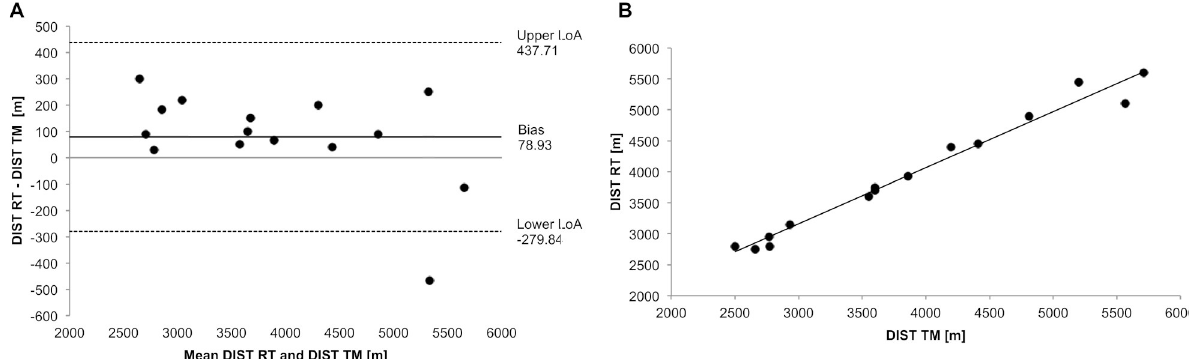
Fig 5. Agreement and strength of the relationship between TM and RT. (A) Bland-Altman plot to show the agreement of DIST and (B) Scatterplot of the DIST achieved for RT (y-axis) versus TM (x-axis) to show strength of relationship.